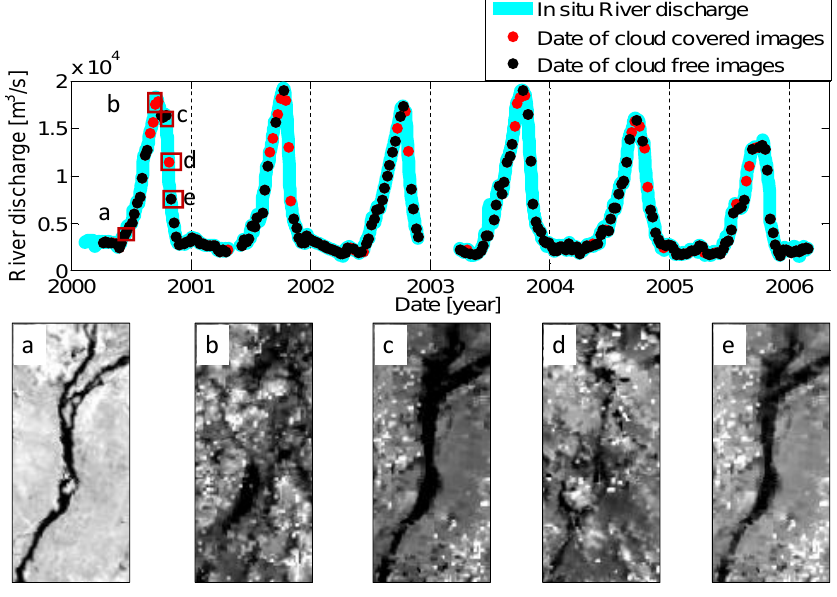
Figure 12. ( a – e ) The cloud detection filters accept images ( a , c , e ), and remove images ( b , d